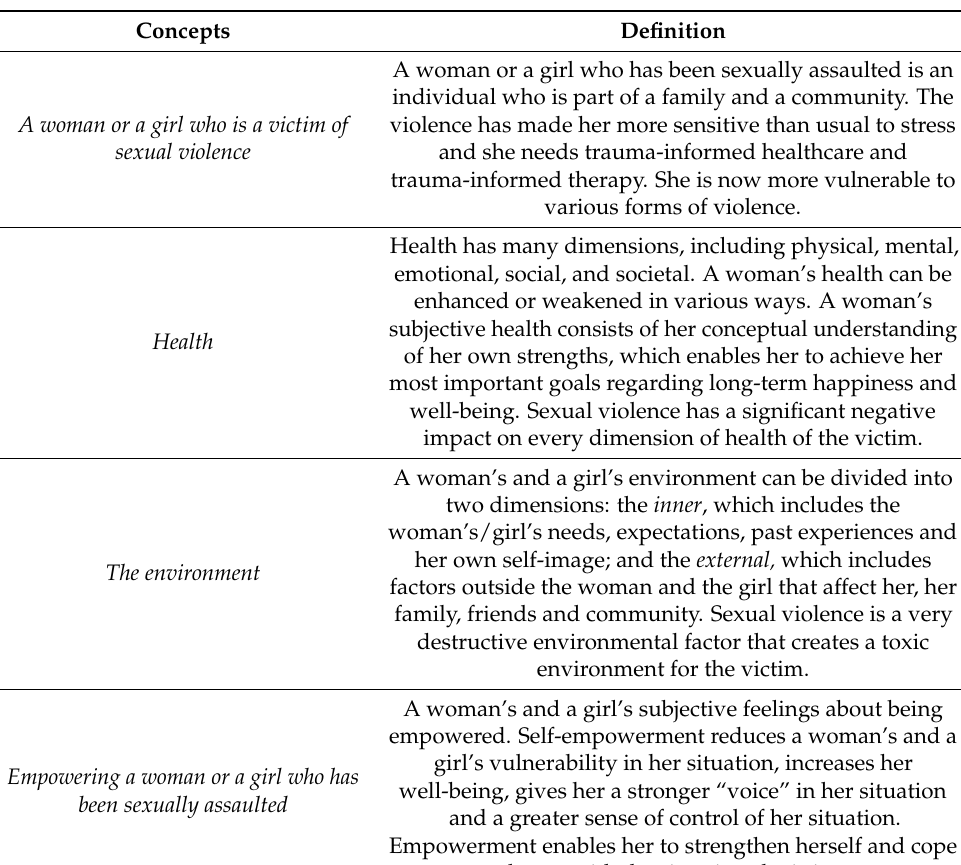
Table 3. Definition of the main concepts of the